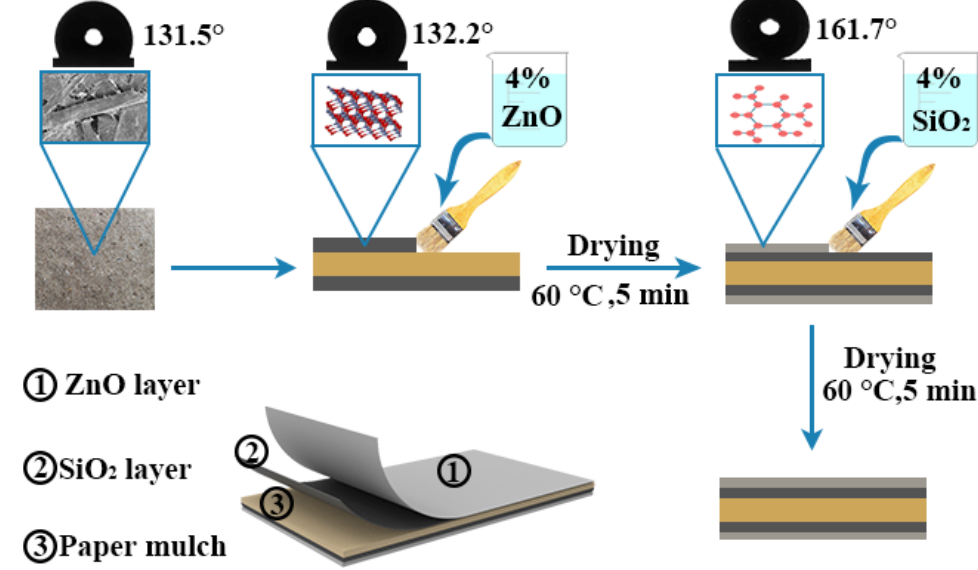
Figure 1. Preparation process of plastic film sample of ZnO/SiO 2 composite coated paper.